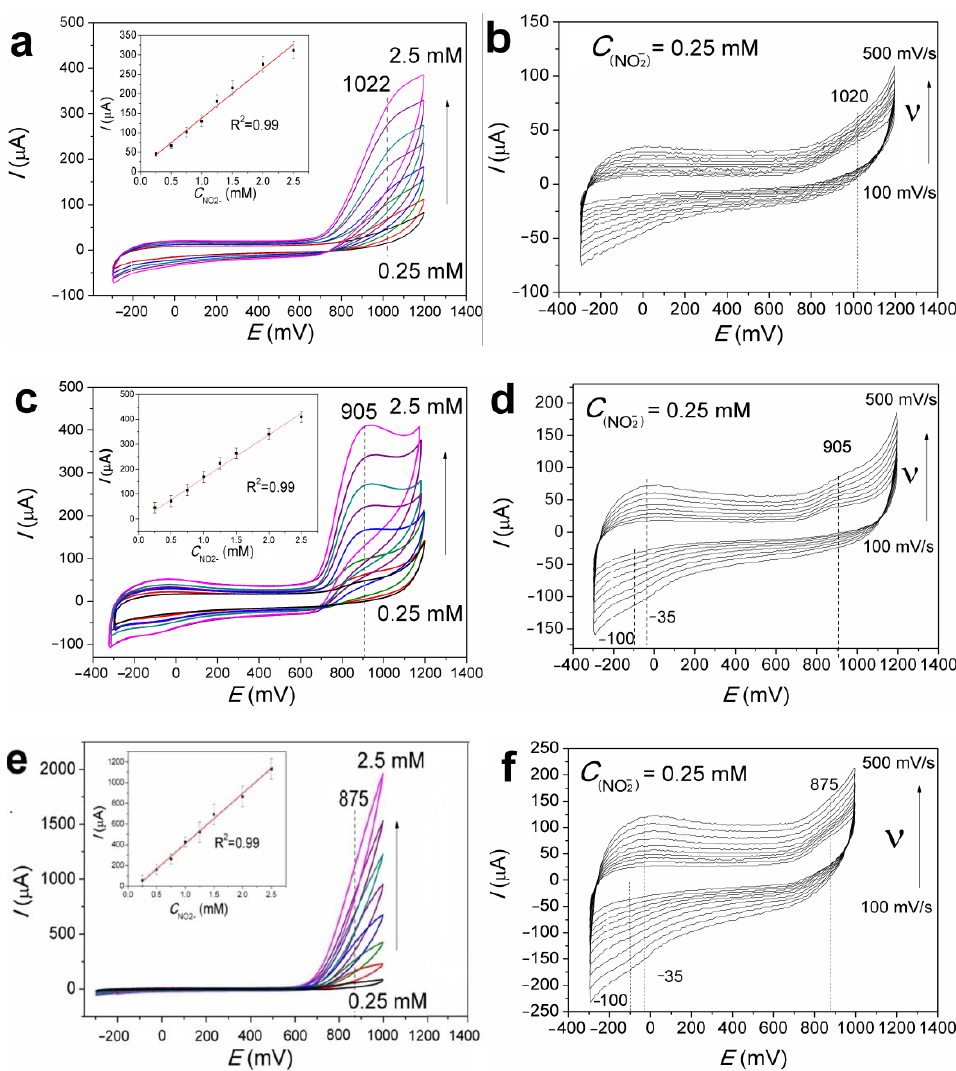
Figure 4. CV curves of the bare GCE, FePc(tBu) 4 /GCE, and Au/FePc(tBu) 4 /GCE in the nitrite concentration range of 0.25 to 2.5 mM ( a , c , e ) and at different scan rates from 100 to 500 mV/s ( b , d , f ). The peaks related to the redox processes of FePc(tBu) 4 are observed at − 100 and − 35 mV, as in the cases of the FePc(tBu) 4 /GCE and Au/FePc(tBu) 4 /GCE (Figure 4). An increase